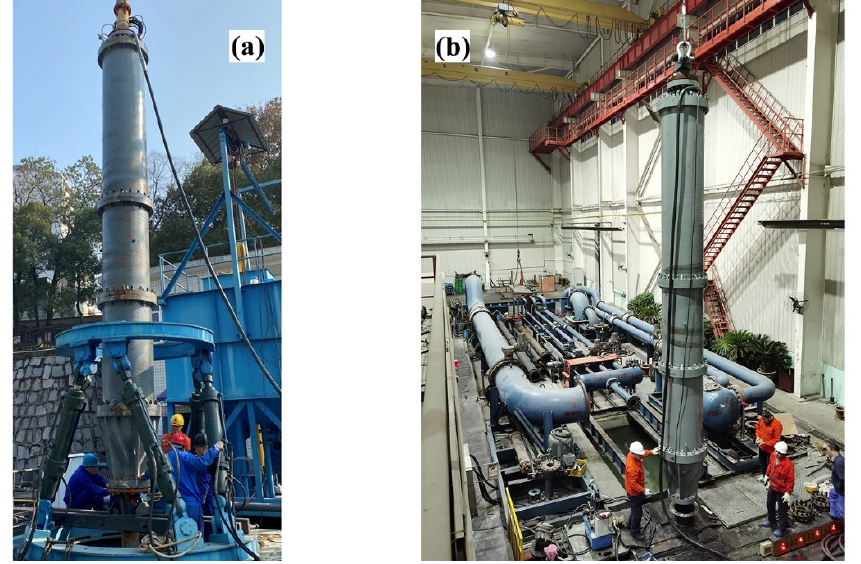
Figure 10. A six-stage centrifugal deep-sea mining pump of Central South University: ( a ) Slurry test site; ( b ) Clear water test site.